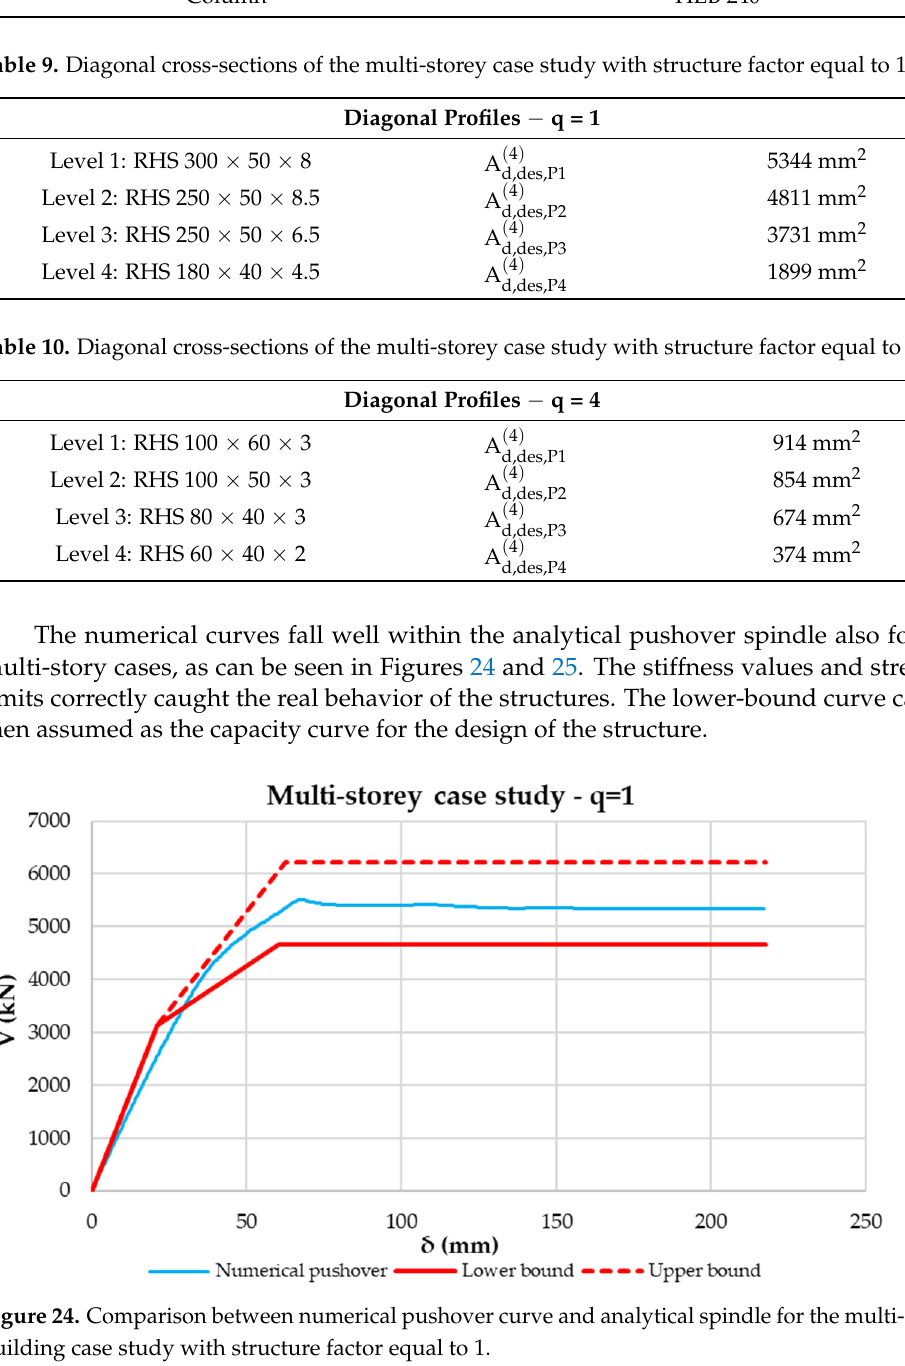
Figure 25. Comparison between numerical pushover curve and analytical spindle for the multi- storey building case study with structure factor equal to 4. 7. Conclusions In the paper, the elasto-plastic behavior of X-concentric braced steel frames with ac- tive tension diagonal bracings was analyzed. The construction of a pushover “spindle”, characterized by two trilinear analytical capacity curves, was defined. The proposal proved to be capable of grasping the real monotonic elasto-plastic behavior of the X-CBFs. The main points developed in the work are listed below: •